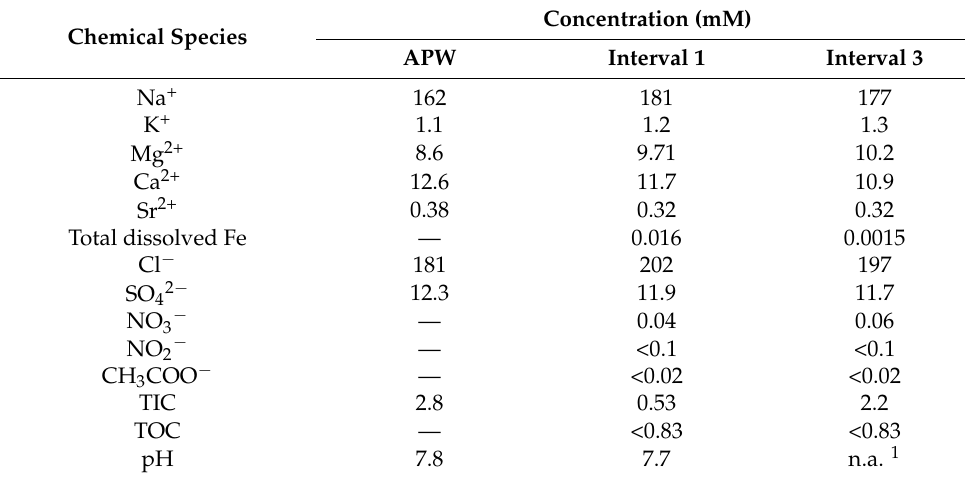
Table 1. Chemical composition of the artificial pore water (APW; target composition [34]) used to saturate the intervals and of sampled solutions from Interval 1 and 3 (one sample each) used for the batch tests (Section 2.2). The measurement uncertainty (95% confidence) on the concentrations is 4–5% ([SO 42 − ]), 5.5% ([NO 3 − ], 6% ([Cl − ]), 10% ([Na + ], [K + ], [Mg 2+ ], [Ca 2+ ], [Sr 2+ ], [CH 3 COO − ], and TIC), 15% ([NO 2 − ], [total dissolved Fe]) and 30% (TOC) (95% confidence), while the uncertainty on the pH is estimated to be 0.1 pH unit (95%